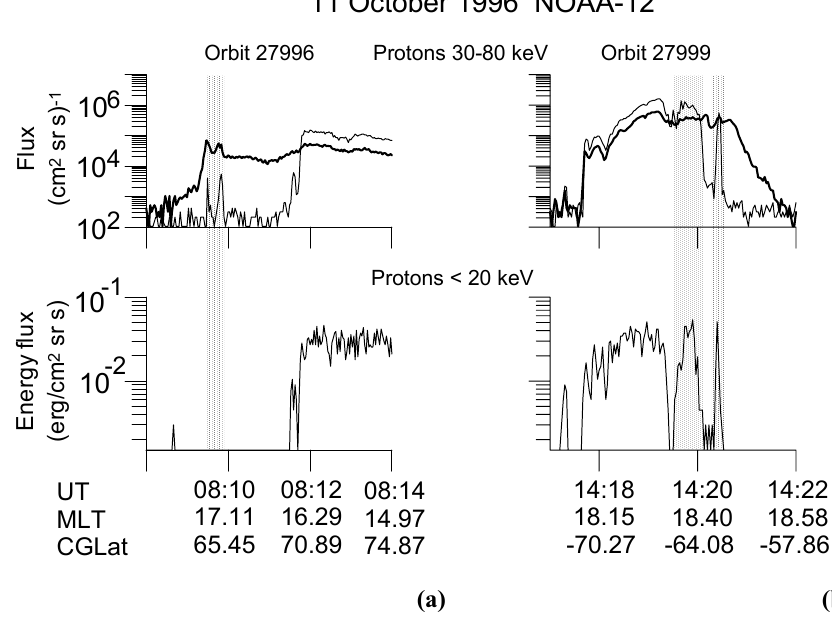
Fig. 1. Examples of localized proton flux enhancements detected in the anisotropic zone by the NOAA-12 satellite. Upper panels shows the data from the MEPED instrument measuring the particles with E > 30keV. Thick line presents trapped flux; thin line presents the precipitating flux. Bottom panels show the data from TED instrument (precipitating particles with E < 20keV). (a) The flux enhancement, which does not contain the low-energy component (Type 1); (b) The flux enhancement with the low-energy component (Type